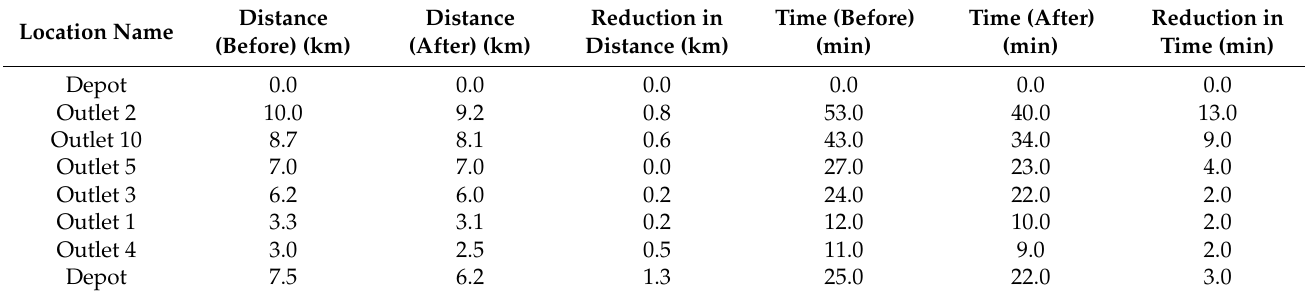
Table 3. Traveling distance before and after using the Intelligent Route Optimizer application for vehicle 1.